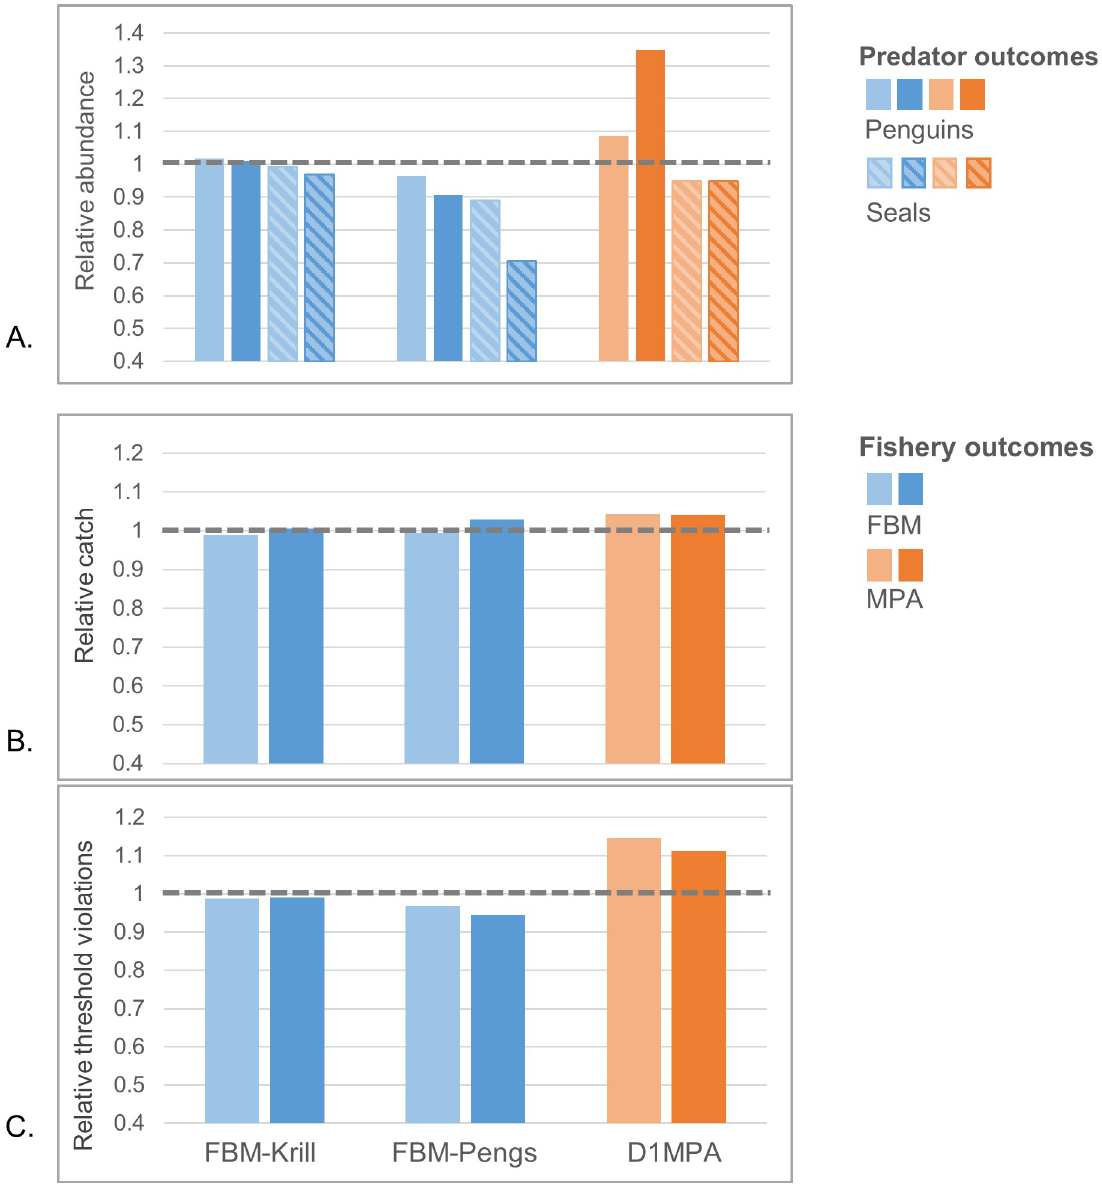
Fig 3. Relative total change in predator abundance (A) and fishery performance (B and C) across modeled scenarios and aggregated at the scale of the full model arena. Lighter shades are at 30 years in the model run, and darker shades at 100 years. Fishery performance is measured both as relative catch (B) and the probability of a threshold violation (C). Feedback strategies are indicated in blue, and the MPA in orange. All results are relative to the No FBM or No MPA scenarios, with the dashed grey line at 1.0 indicating no impact of FBM or the